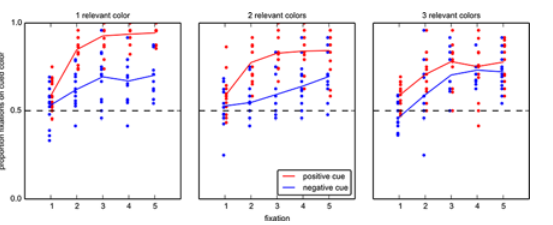
Fig 9. Proportion of fixations on relevant items for the first five fixations in each trial in experiment 2. Left: relevant items are of one color, middle: relevant items are of two colors, right: relevant items are of three colors. The same general pattern as seen in Fig 6 can be observed for each number of relevant colors in the array. The first fixation following a negative cue of one irrelevant color (leaving three relevant colors) might be guided towards this color – it is the only average that is below chance level – but this is not significant. Positive cues immediately guide participants ’ gaze toward relevant items. Negative cues also provide correct guidance, but this develops more slowly than for positive